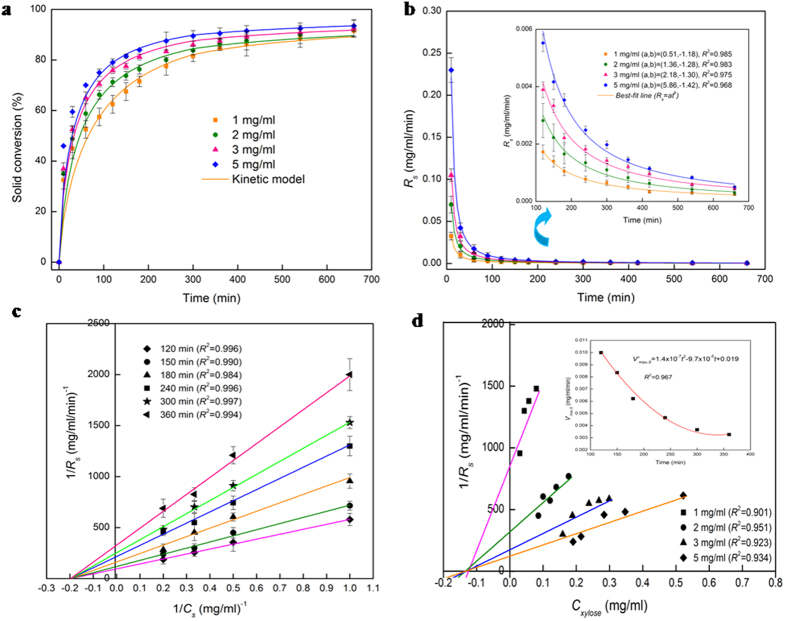
Solid hemicellulose conversion and solubilization rate, phase transition, and product inhibition.(a) Temporal dynamics of solid hemicellulose conversion in enzymatic hydrolysis. (b) Temporal variation of hemicellulose solubilization rate (Rs) from the solid phase. (c) Non-competitive product inhibition in the solid phase. (d) Xylose inhibition in the solid phase. In (a) solid conversion (≥92%) at 11 h suggests the transition from two-phase (solid-liquid) hydrolysis to a single (liquid) phase one. Inset of (d) is the plot of apparent maximum velocity (V′max,s) versus time, and the maximum reaction rate (Vmax,s) is the extrapolated value of the fitted quadratic expression to t = 0. Solid points are the experimental results and the solid lines represent the simulation results (a) and the best-fit curves (b,c,d).